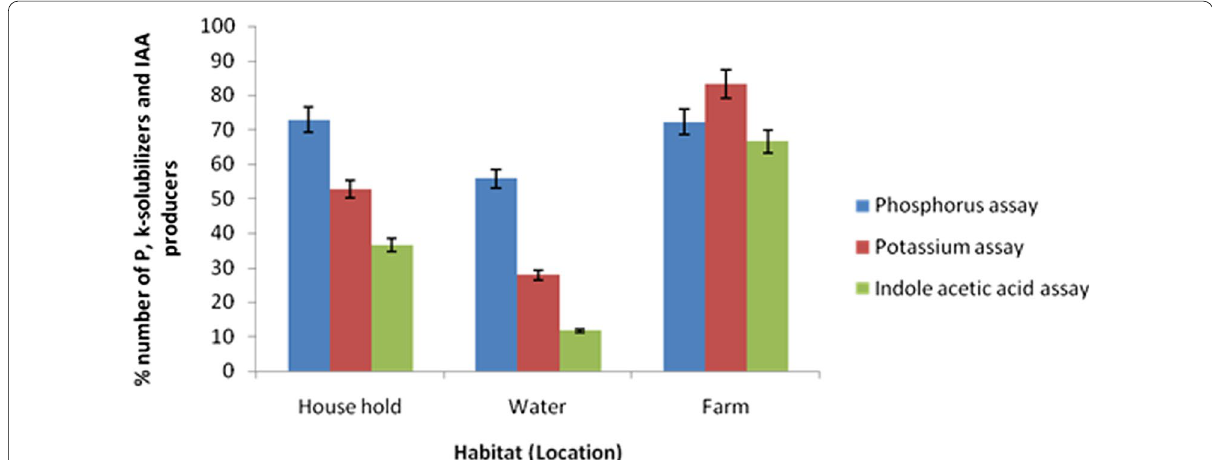
Fig. 2 Percentage prevalence of P, K-solubilizers and IAA producers at different locations